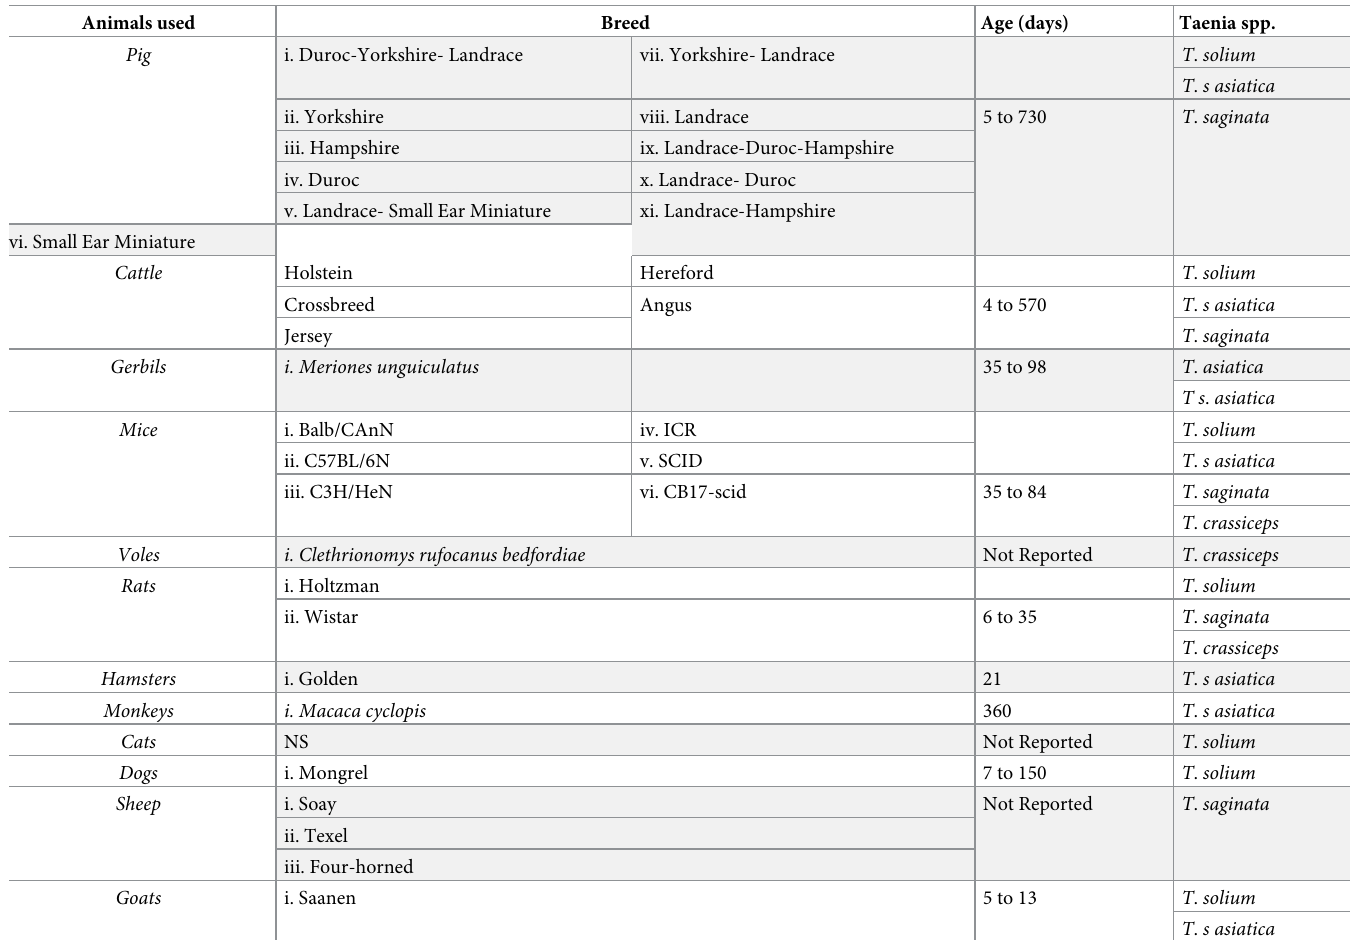
Table 8. Breed, Taenia spp. and age of animals used in experimental models. Animals used Breed Age (days) Taenia spp.